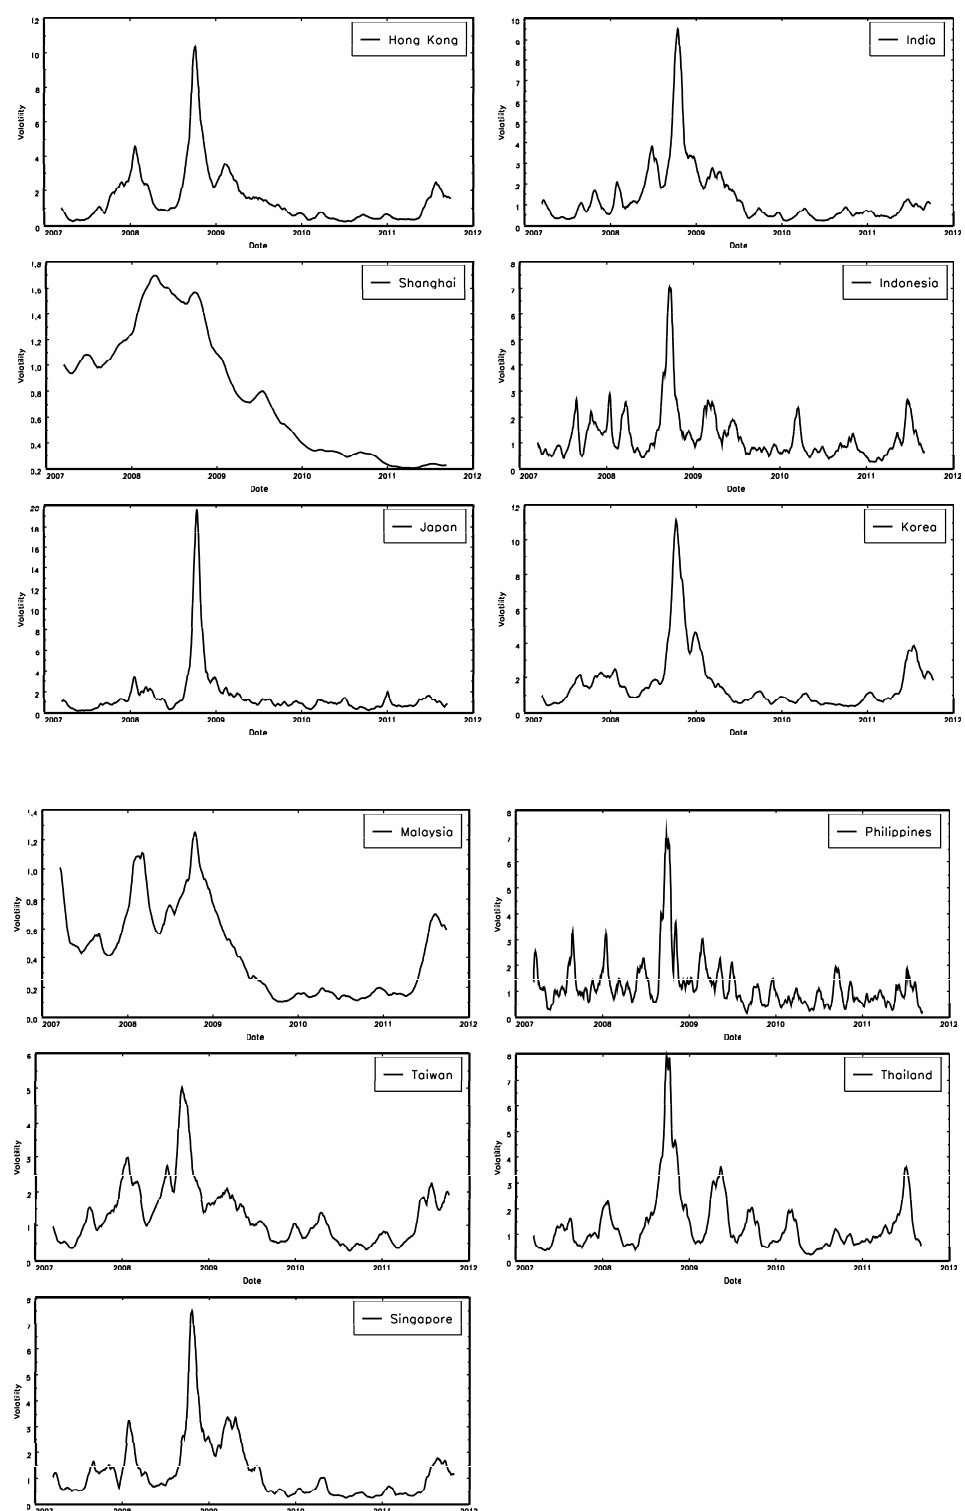
Figure 1. Stochastic volatilities for the eleven stock indexes. Notes : The figure depicts the stochastic volatilities for the log of squared returns: (from top left to the right and down) Hong Kong, India, Shanghai, Indonesia, Japan, Korea, Malaysia, Philippines, Taiwan, Thailand, and